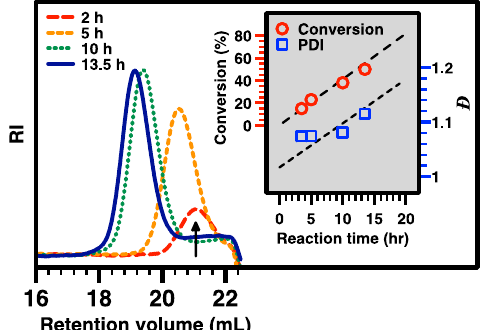
Figure 8. GPC curve evolution during the ROP process to form APCL. A shift toward higher molecular weight was observed, showing the progress of the ROP reaction. The inserted graph represents the conversion of reaction (by 1 H NMR analysis) and Đ GPC (i.e., PDI) of APCL vs. reaction time.